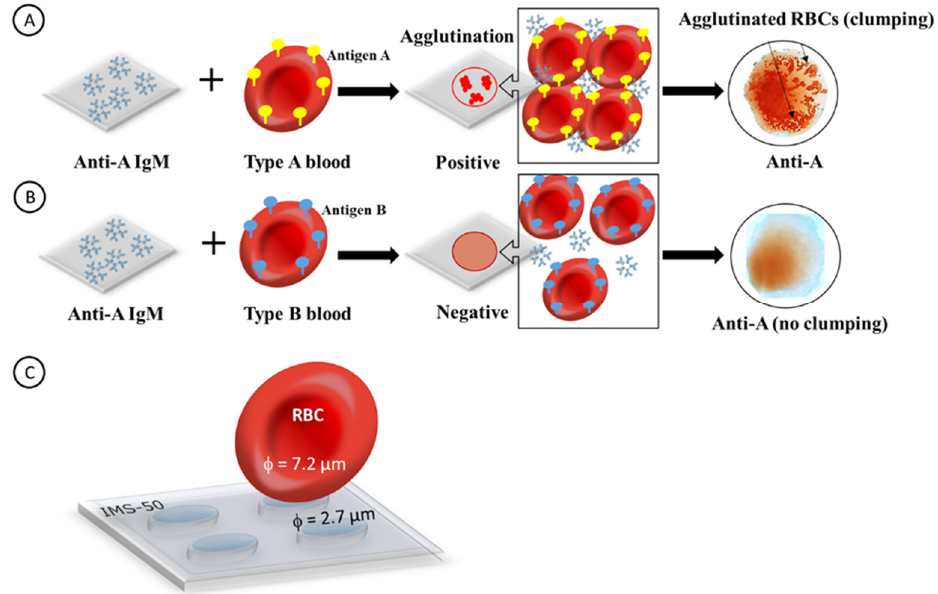
Figure 1. Schematic representation of the interactions of an antibody with RBCs on a paper immunostrip. ( A ) positive test: agglutination process between anti-A IgM and blood type A, ( B ) negative result: no agglutination process between anti-A IgM on paper and blood type B in the droplet, and ( C ) scheme of the RBCs deposition on the cellulose paper immunostrips IMS-50 with 2.7 µm pores.